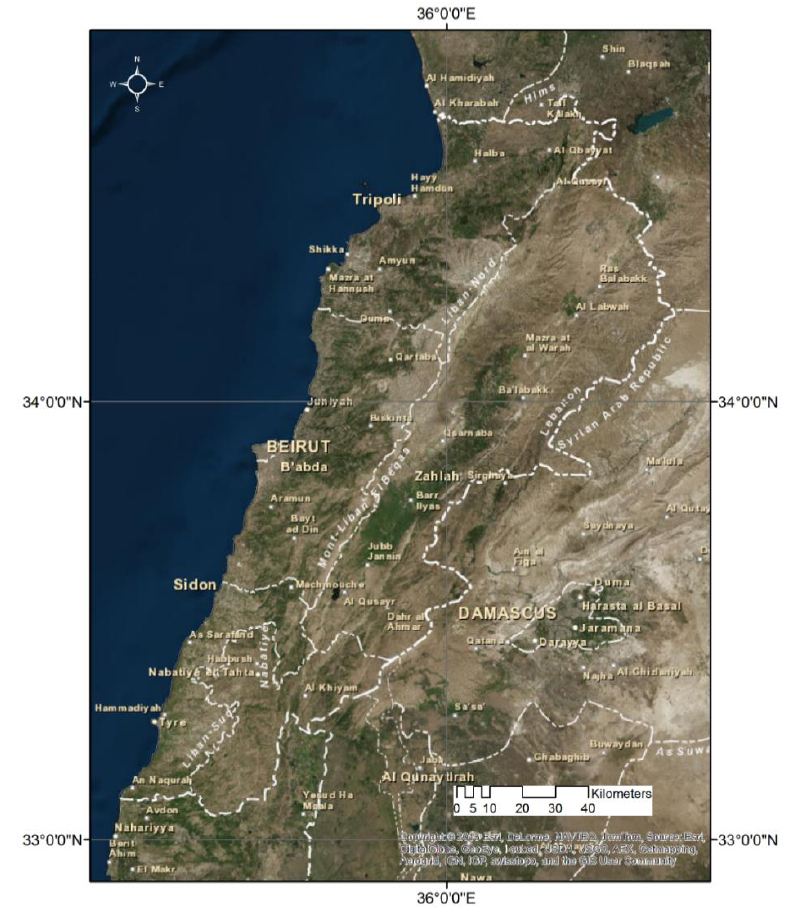
Figure 1. National geographic map of